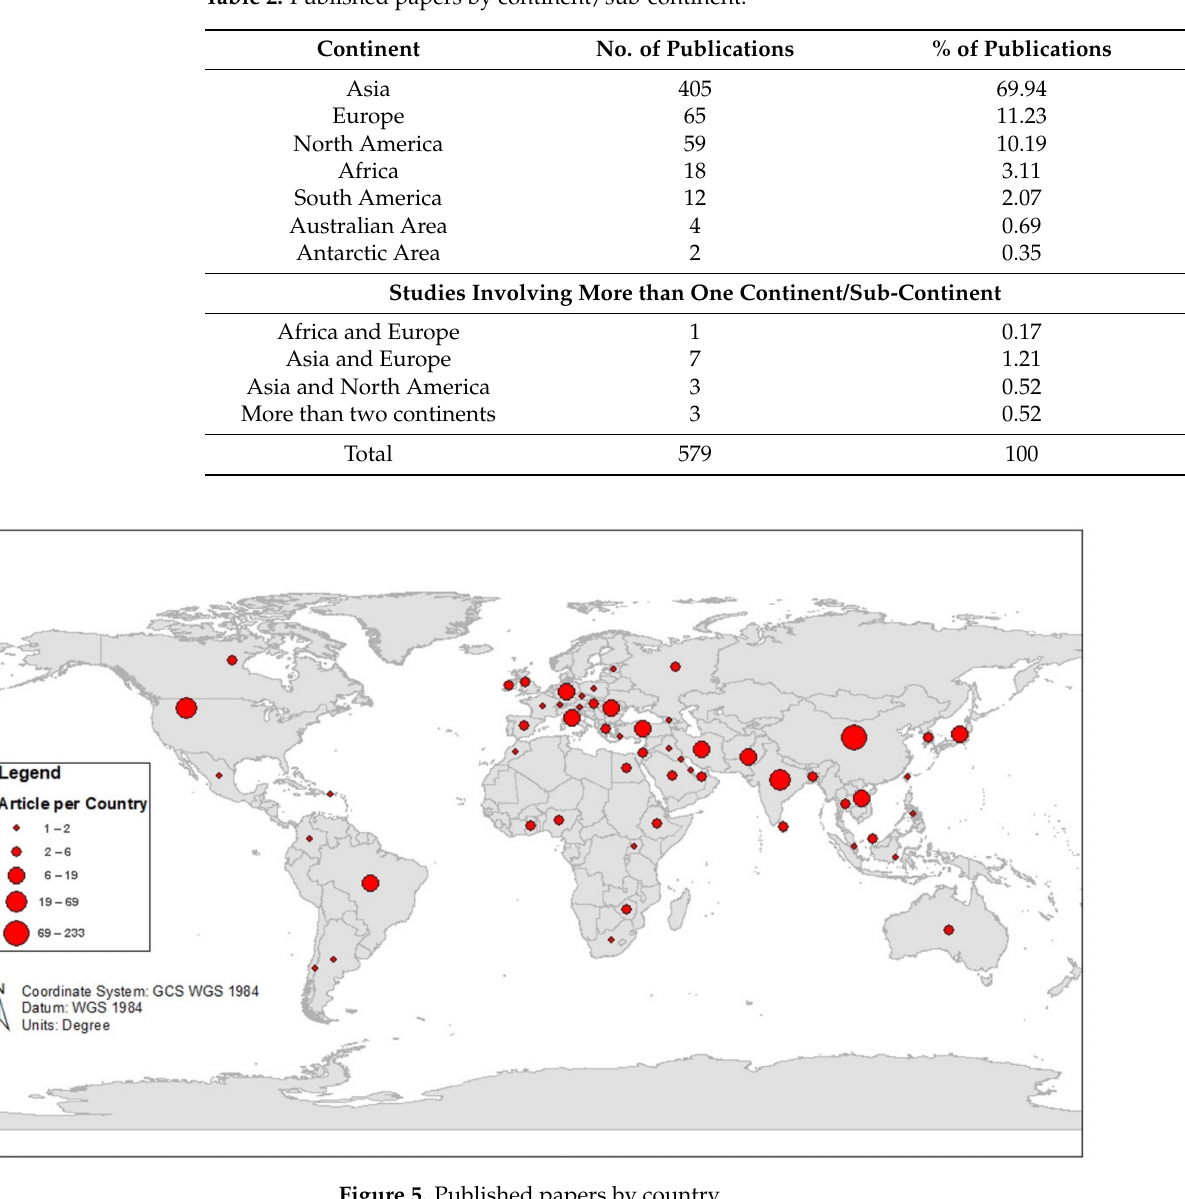
Figure 5. Published papers by